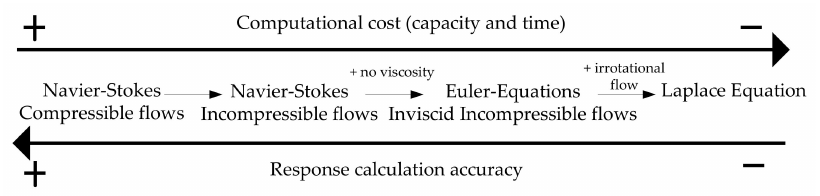
Figure 1. Contradiction between response calculation accuracy and computational